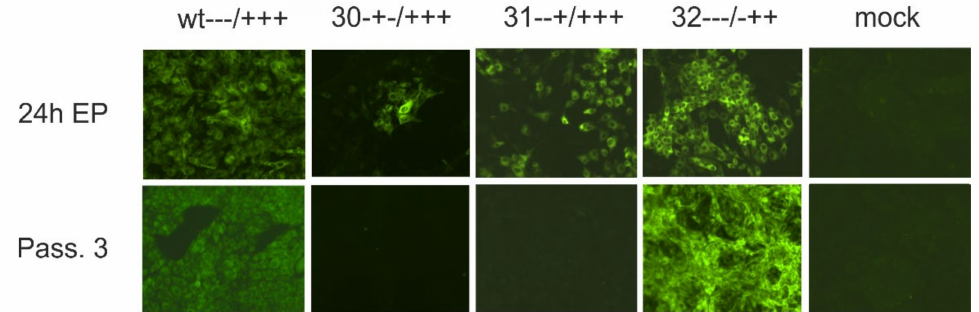
Figure 13. Exchange of charged residues in the E rns membrane anchor can block production of infectious virus. Immunofluorescence analyses conducted after transfection of CSFV genome-like wt RNA or RNA with the given selected exchanges of one triplet coding for a charged amino acid in the carboxy-terminal region of E rns . The upper row shows results of analyses conducted ca. 24 h post electroporation and proves that all tested RNAs represent functional replicons. The lower row shows the results obtained after three passages of cell culture supernatant used for infection of fresh cells. Immunofluorescence was done with mab a18 directed against the E2 protein [33]. “-“ represents a negative, “+” a positive charge. Magnification 100 ×